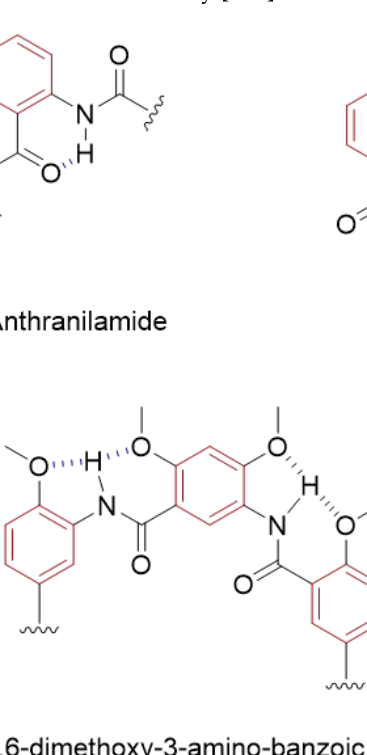
Figure 3. Structures of aromatic foldamers.